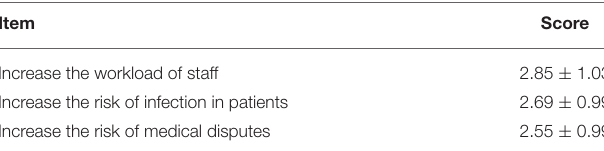
TABLE 4 | Disadvantages score of neonatal ultrasound localization (score, ¯ x ±